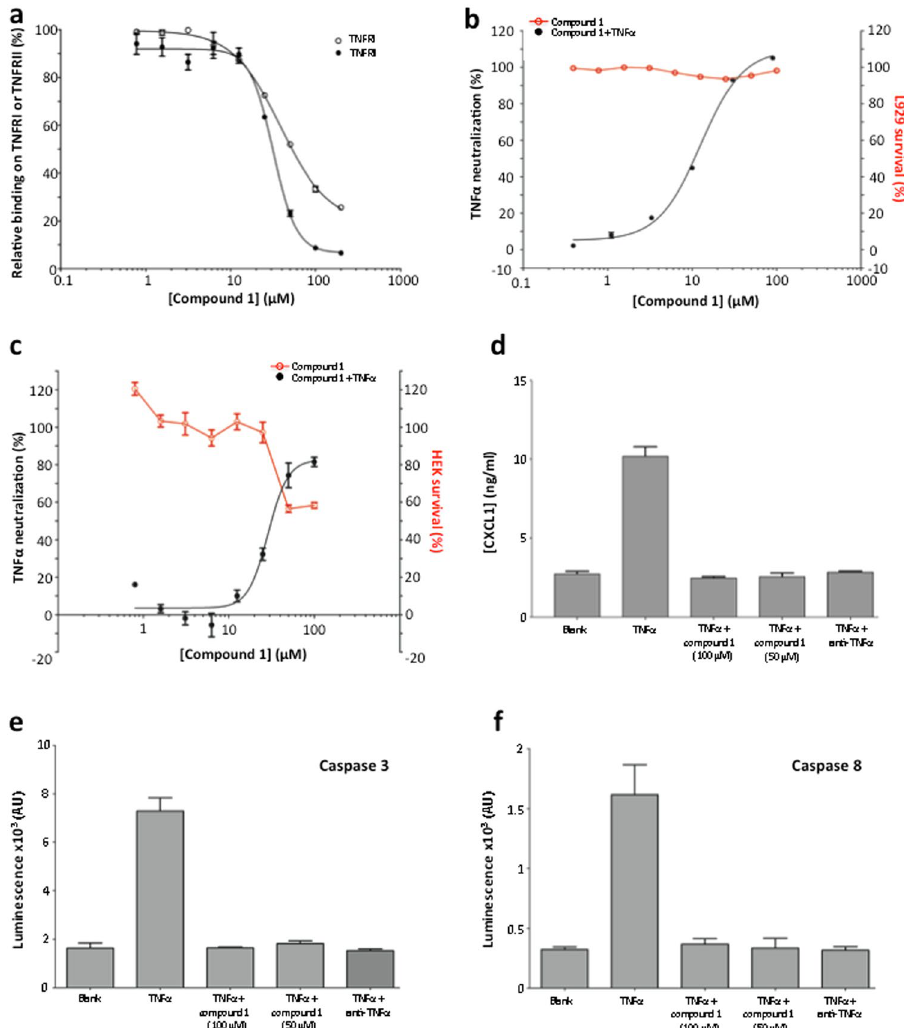
Figure 4. ( a ) Relative binding on TNFRI and TNFRII. Compound 1 inhibits the interaction between TNF α and its receptors TNFRI and TNFRII in a dose dependant manner. TNFRI IC 50 = 37 μ M, TNFRII IC 50 = 31 μ M. ( b ) Neutralization of TNF α and survival of L929 cells. Compound 1 inhibition of TNF α induced apoptosis in L929 cell line. Data represent neutralization of TNF α in presence of various concentrations of compound 1. IC 50 = 12 μ M ( c ) Neutralization of TNF α and survival of HEK cells. Compound 1 inhibition of the TNF α signaling pathway on HEK cells transfected with a reporter gene under the control of NF- κ B. Data represent the neutralization of TNF α in the presence of different concentrations of compound 1. IC 50 = 10 μ M. ( d ) Inhibition of CXCL1 secretion in L929 supernatants in presence of various concentrations of compound 1 after stimulation with TNF α (5 ng/ml). ( e ) Inhibition of caspase 3 activity in presence of compound 1. ( f ) Inhibition of caspase 8 activity in presence of compound